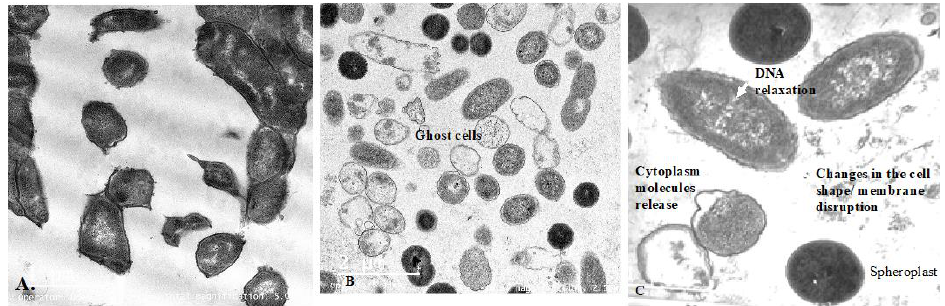
Figure 7. TEM micrograph of Salmonella enterica subsp. enterica untreated ( A ) and treated with T6 formulation ( B , C ). Bar = 1, 2 μm.